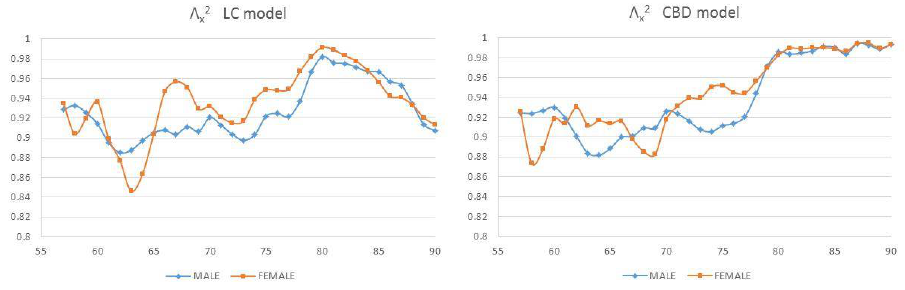
Figure 3. Proportion of temporal variance explained by the models: